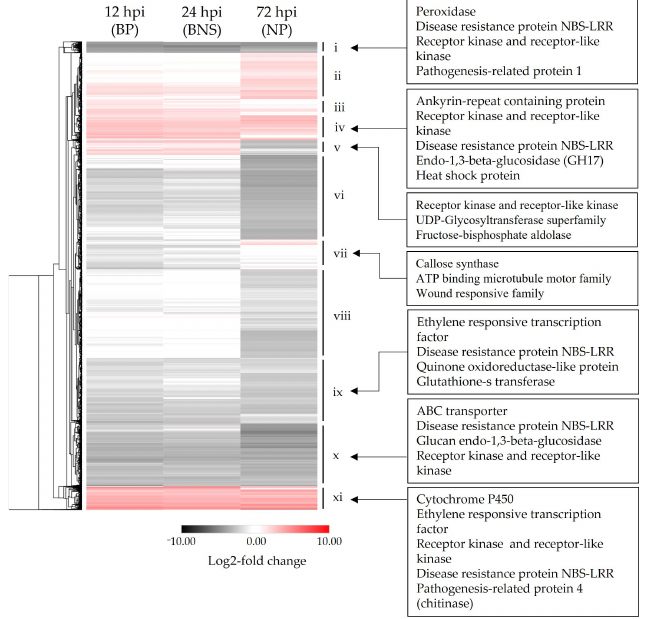
Figure 4. Clusters of significantly differentially regulated chickpea genes display conserved expres- sion patterns across three phases of Phytophthora medicaginis colonisation. Hierarchical clustering of the log2-transformed data of 13,568 significantly regulated genes of chickpea variety ‘Sonali’ during the three phases of colonisation by P. medicaginis are represented (padj-value < 0.05, 1 < log2FC > − 1). All data points are the ratio of transcript abundance in colonised roots as compared to control plants grown under the same conditions where red value indicates increased gene expression and black/grey indicates decreased gene expression. The heat map is annotated on the left-hand side with the hierarchical cluster groupings denoted i–xi. BP: biotrophic phase, BNS: biotrophy to necrotrophy switch, hpi: hours post-inoculation, NBS-LRR: nucleotide-binding site-leucine-rich repeat and NP: necrotrophic